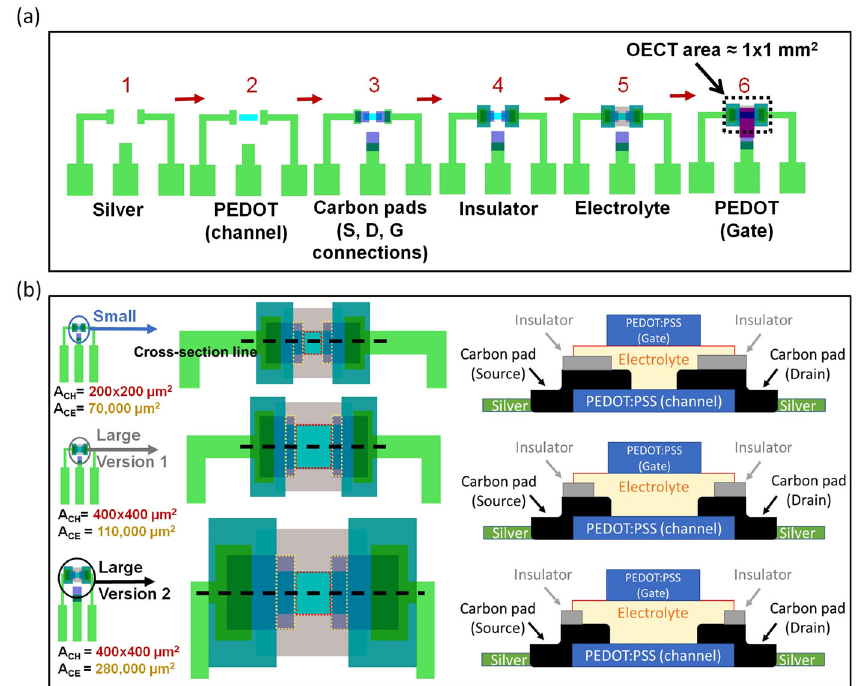
Fig. 2 Detailed schematics of OECT layouts. a Sequence of six printed layers and the approximate footprint per OECT, b three different OECT architectures with different channel areas ( A CH indicated via red dashed squares) and carbon areas exposed to the electrolyte ( A CE indicated via yellow dashed rectangles) are shown with the corresponding top and cross-sectional views for each OECT geometry. The multi-layered stacks in the cross-sectional views are schematically showing how channel length and A CE vary for the three OECT